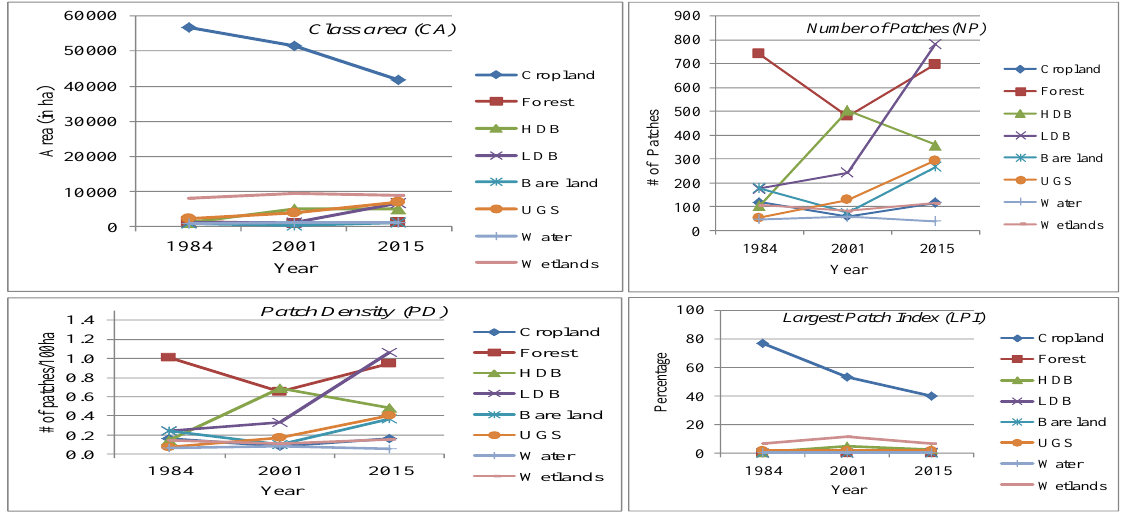
Figure 3: Evolution of landscape composition